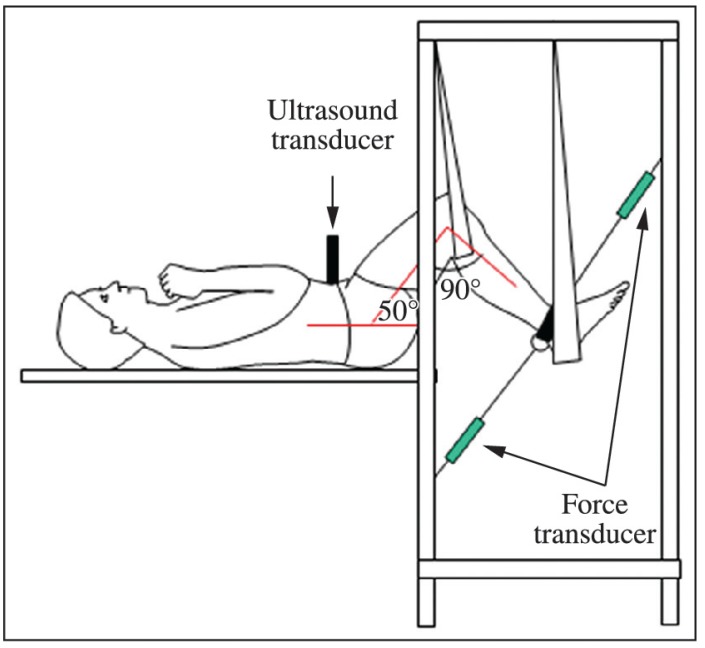
Diagram of the device used to position the participant during ultrasound
image collection. Source: Ferreira et al.12 (used with permission).